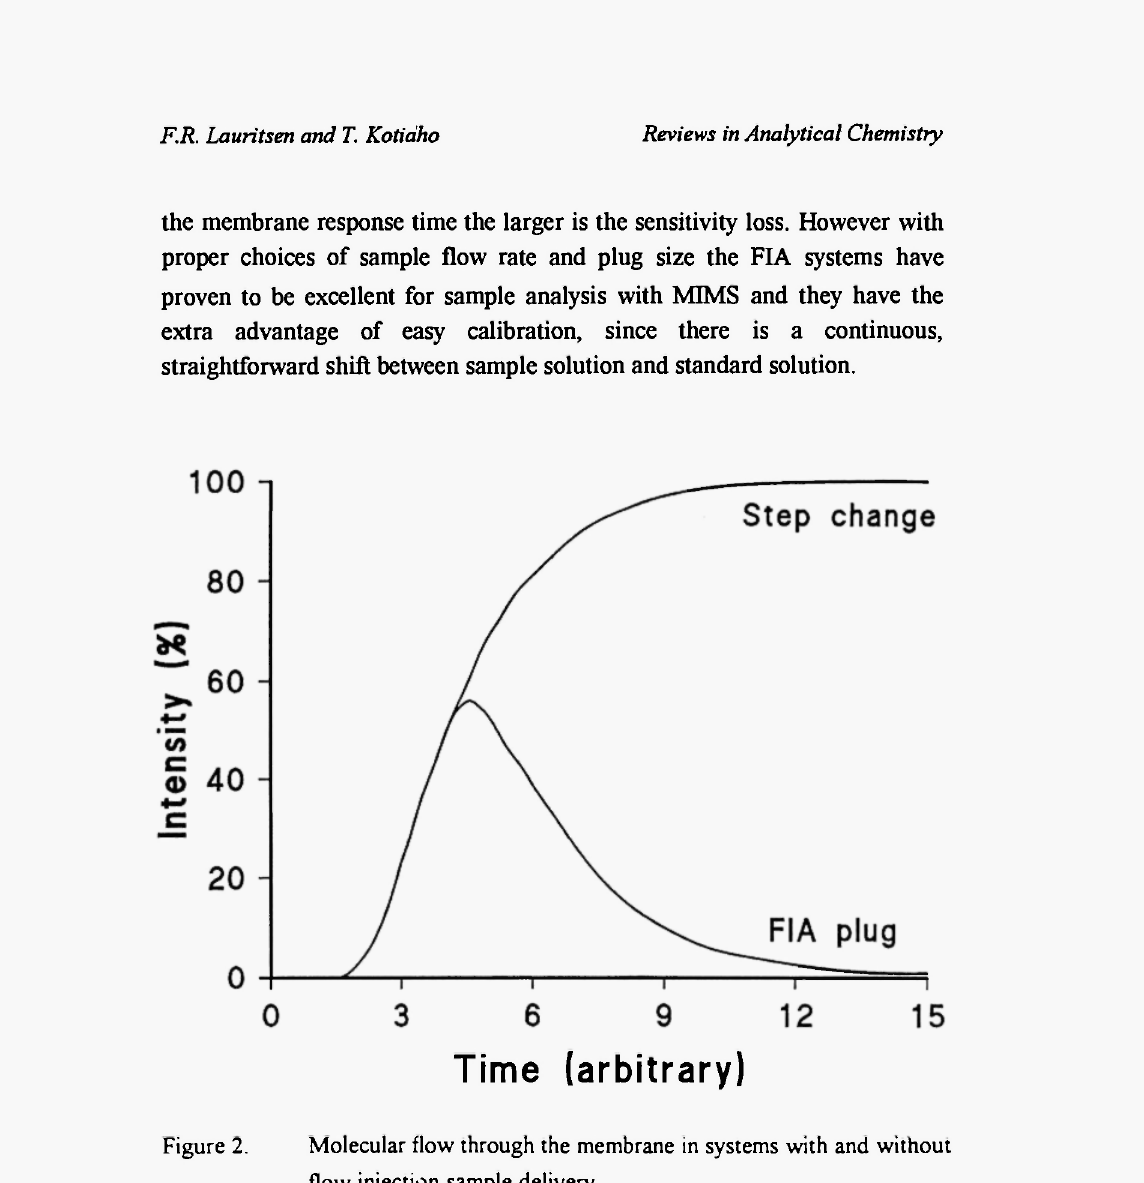
Figure 2. Molecular flow through the membrane in systems with and without flow injection sample